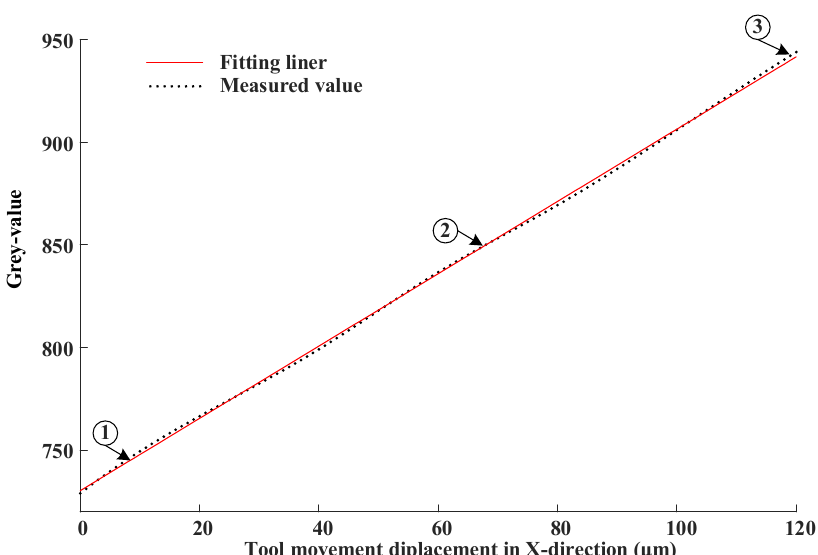
Figure 5. Output in terms of gray values vs. tool displacement change in x-direction. (7) The maximum linear error is 1.5% between the fitting line and measurement data. 𝑓𝑓 ( 𝑥𝑥 ) = 1.76 𝑥𝑥 + 730.5